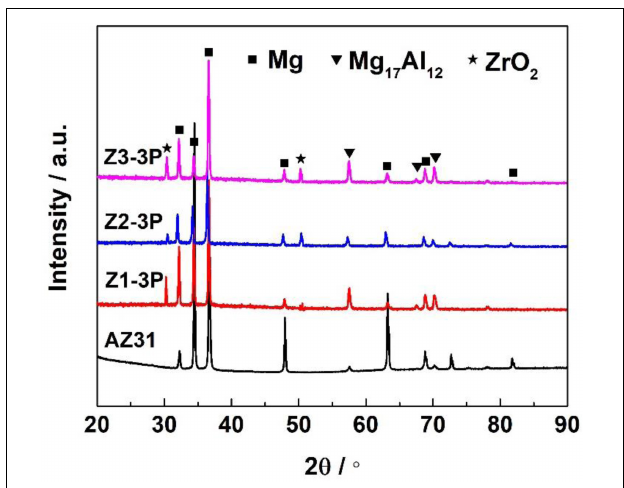
FIGURE 9 | TEM images of FSPed AZ31/ZrO 2 composite (Z3-3P specimen): (a) distribution of ZrO 2 particles, (b) selected area diffraction pattern, (c) high-resolution TEM micrograph, and (d) interface between the Mg matrix and ZrO 2